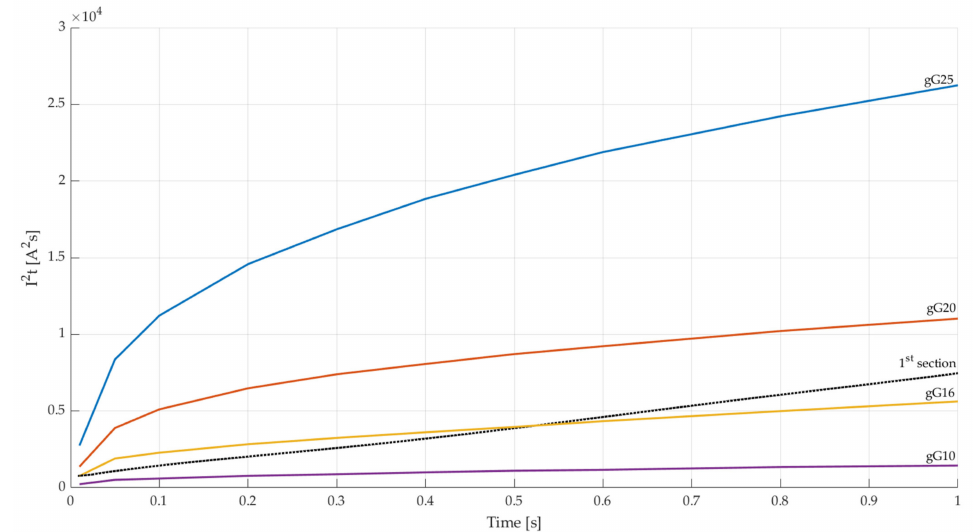
Figure 7. The fuses Joule’s integrals and real measured energy comparison for fault after first line